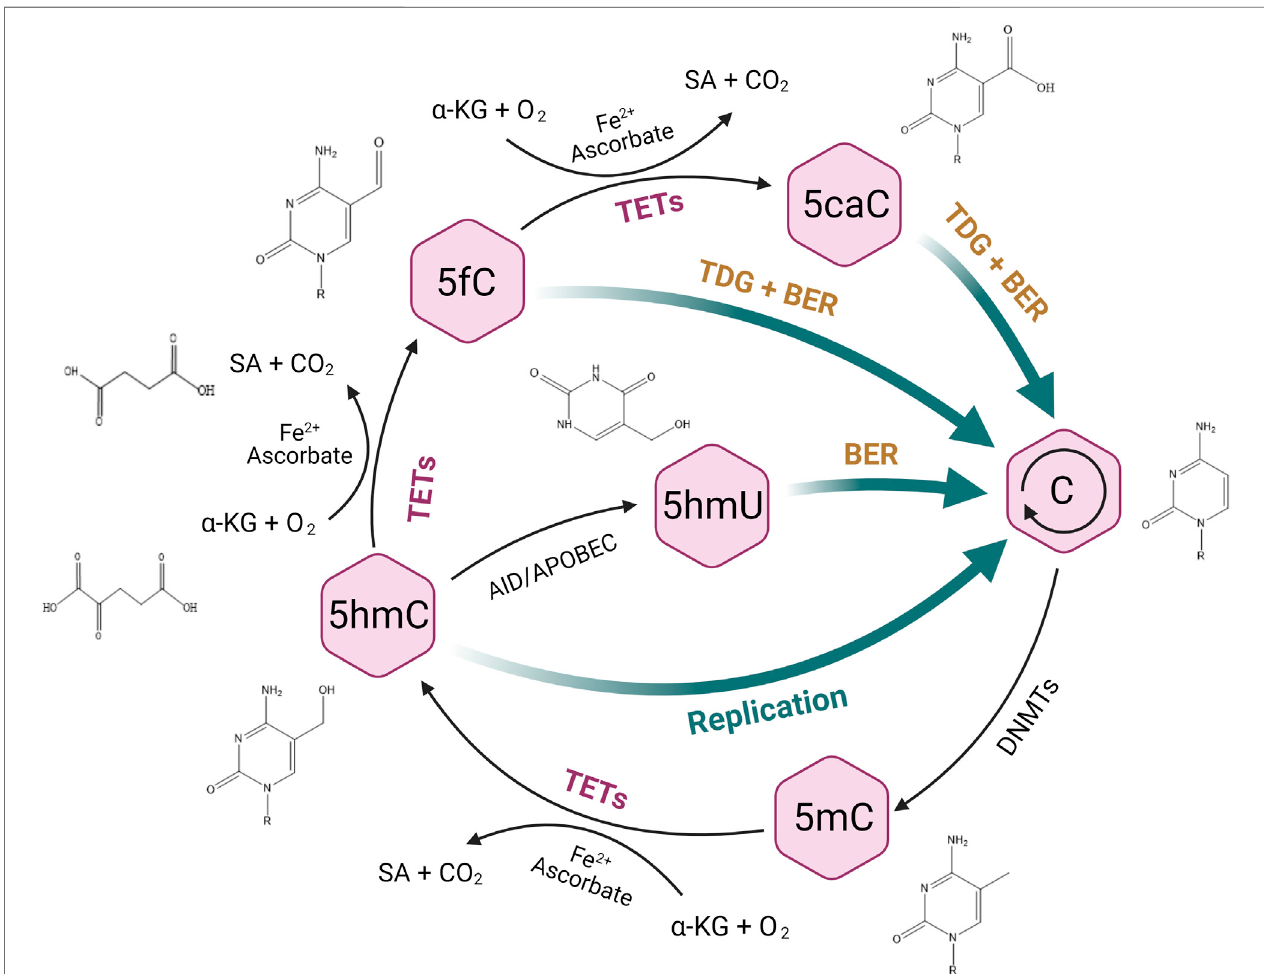
FIGURE 1 | TET-mediated DNA demethylation process. TET enzymes can oxidize 5-methylcytosine (5mC) to 5-hydroxymethylcytosine (5hmC), and further to 5- formylcytosine (5fC) and 5-carboxylcytosine (5caC), followed by the excision of 5fC and 5caC via thymine DNA glycosylase (TDG) and the replacement of unmethylated cytosine through base-excision repair (BER). 5hmC can also be deaminated to 5-hydroxymethyluracil (5hmU) by AID/APOBEC enzymes and subsequently to an unnmethylated status by BER.